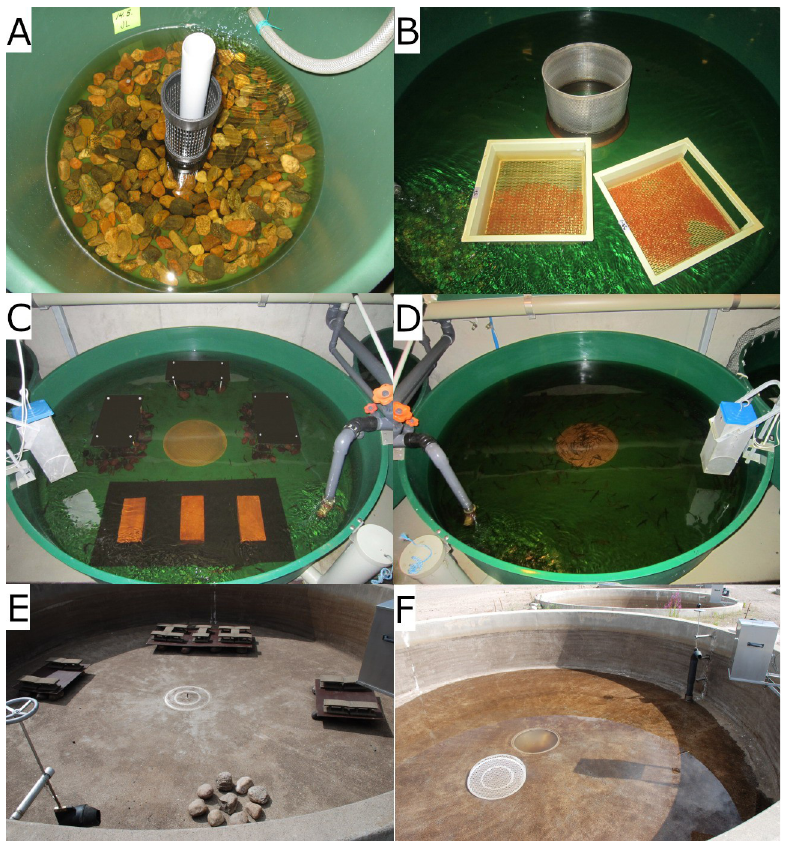
Fig 1. Enriched (left) and standard (right) rearing tanks during egg incubation (A–B), first year of living (juvenile stage; C–D), and on-growing (until smolt stage; E–F). Enriched and standard tanks at different stages of rearing.